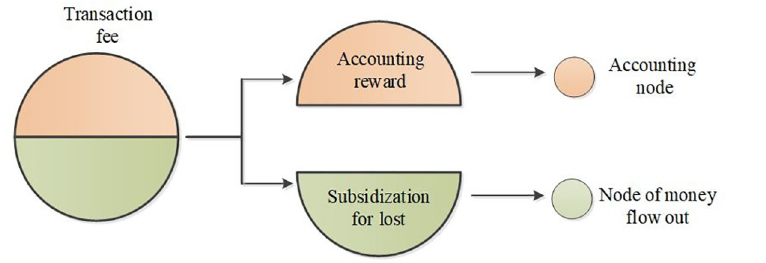
Fig 6. The division of transaction